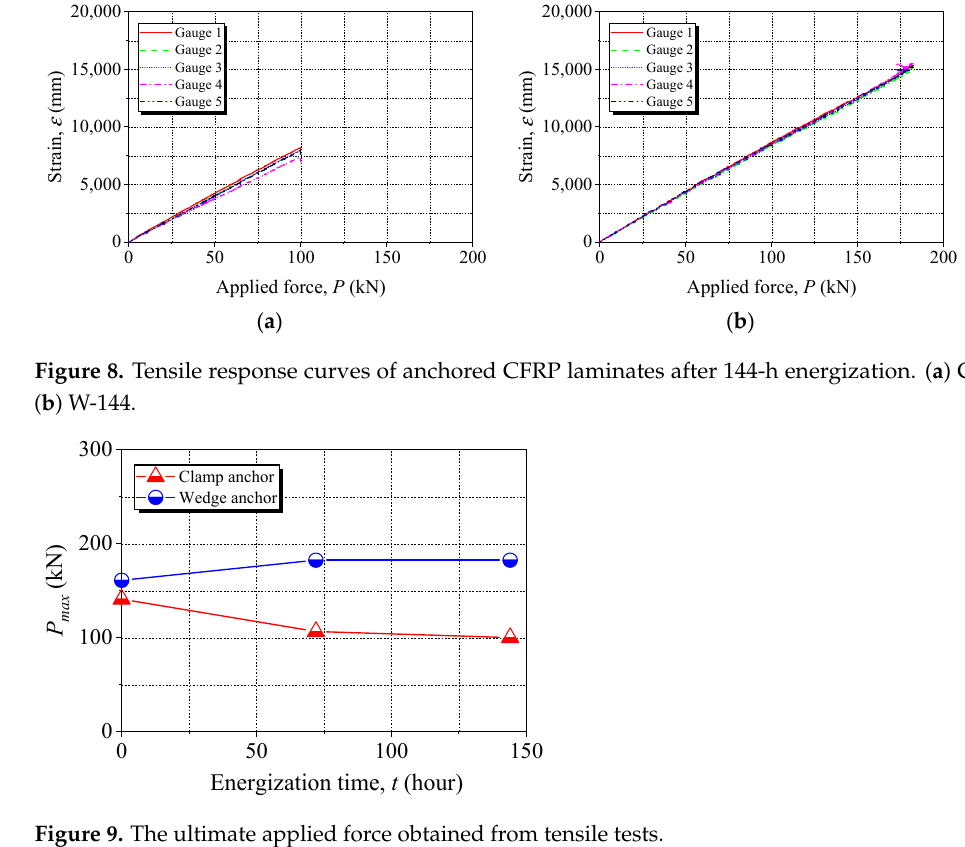
Figure 9. The ultimate applied force obtained from tensile tests.